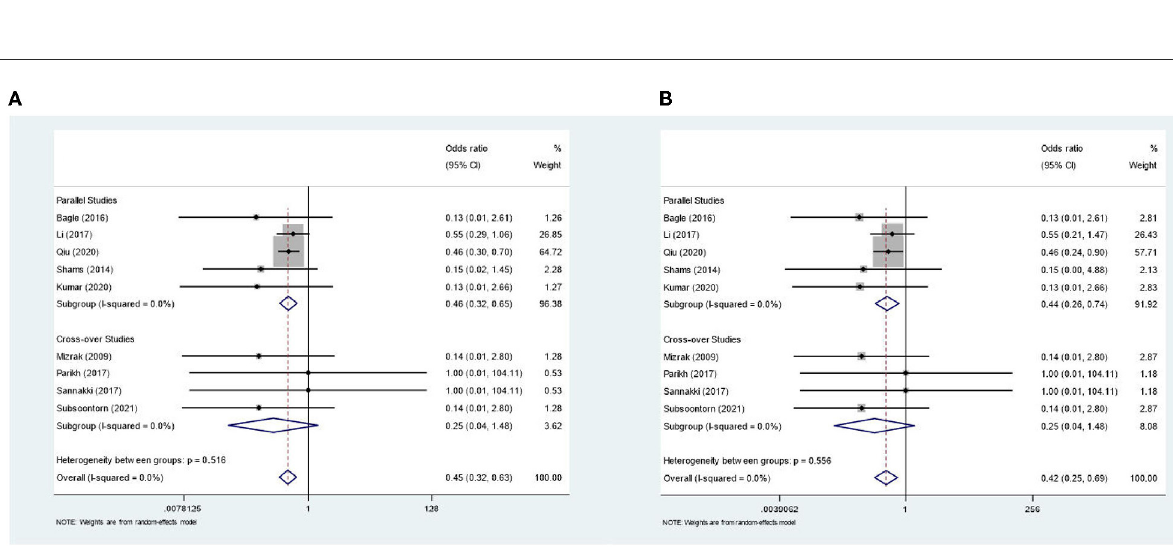
FIGURE3 Sensitivity analyses for lower- and upper end intra-class correlation. (A) Forest plot for lower-end value of intra-class correlation ( = 0.196). (B) Forest plot for upper-end value of intra-class correlation ( =